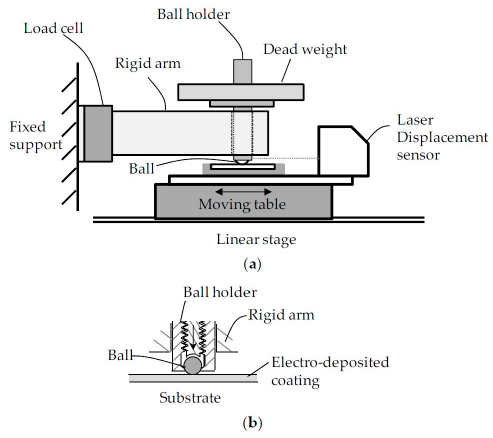
Figure 1. Schematic illustration of the test apparatus: ( a ) the side view of a fretting test rig; ( b ) ball-on-flat contact geometry.